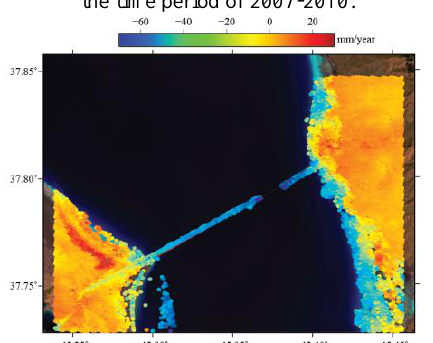
Figure 4. LOS deformation velocity map derived from ALOS in the time period of 2007-2010.